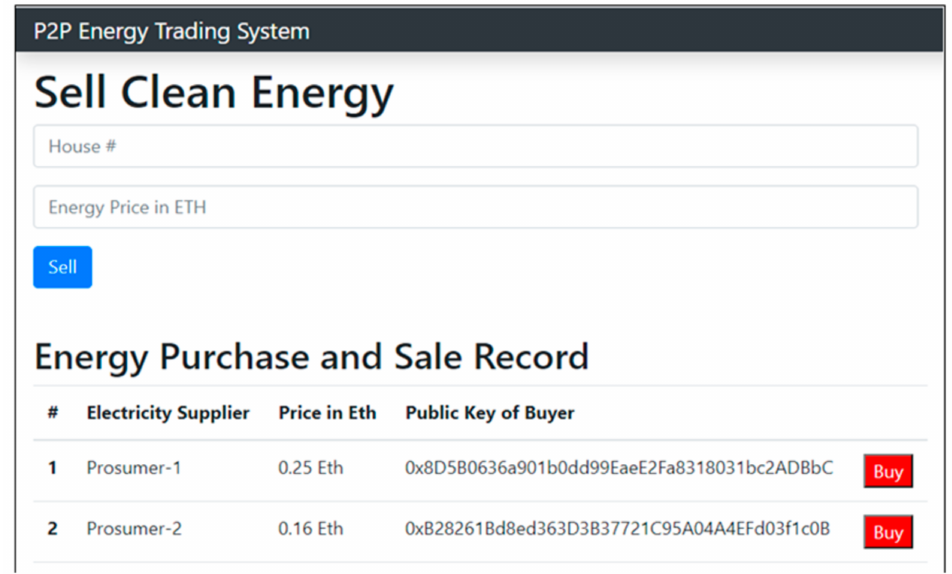
Figure 14. Web App UI in MetaMask